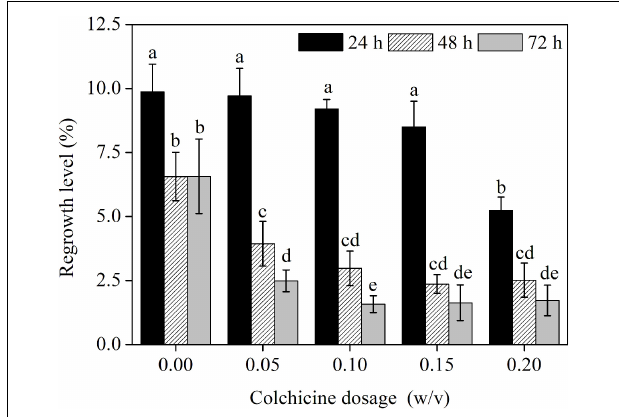
FIGURE 5 | The effects of colchicine treatments on the regrowth levels of ECAs of Magnolia officinalis . Data are mean ± SD of three replicates. Means with different letters are significantly different ( p < 0.05).